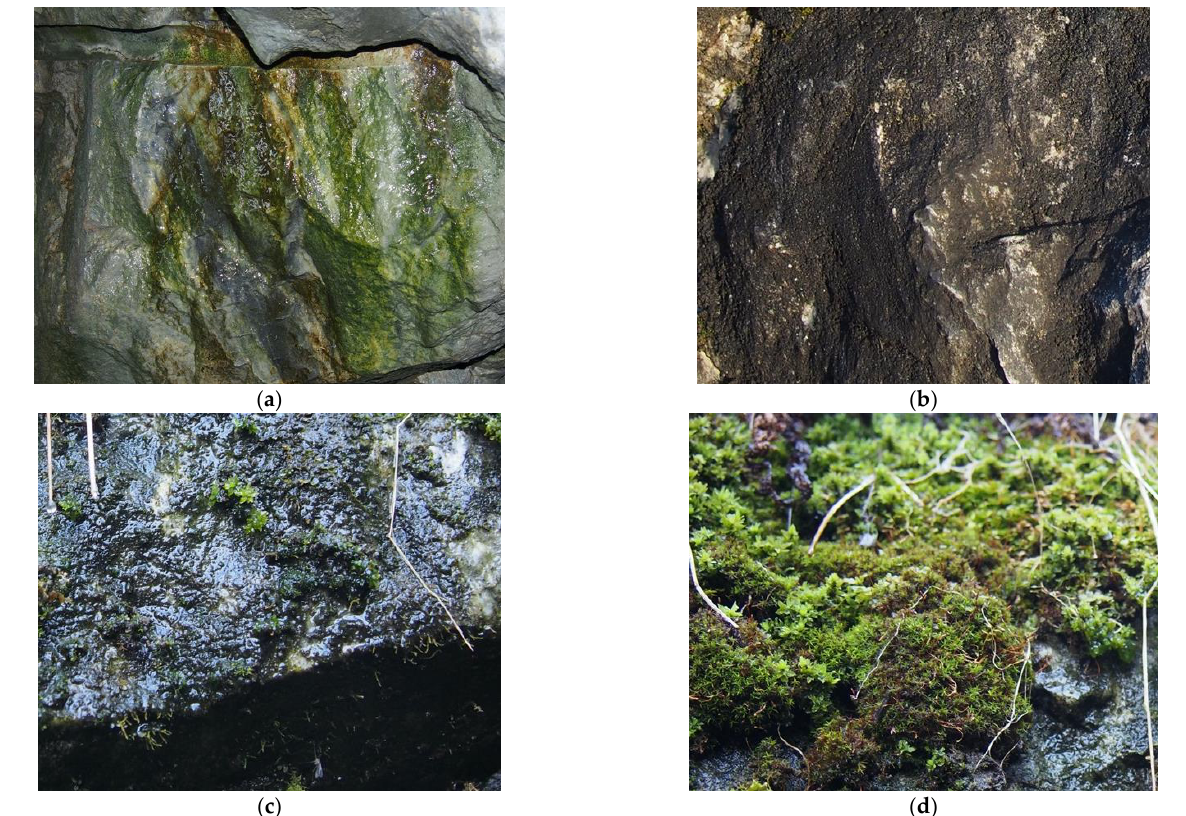
Figure 3. The main types of biolayers on the surface of stone in Ruskeala quarry: ( a ) biolayers with a predominance of microscopic algae and cyanobacteria; ( b ) biolayers with a predominance of fungi; ( c ) biolayers including individual tussocks of mosses and lichen thalli; ( d ) moss and primary soil under the moss cover.